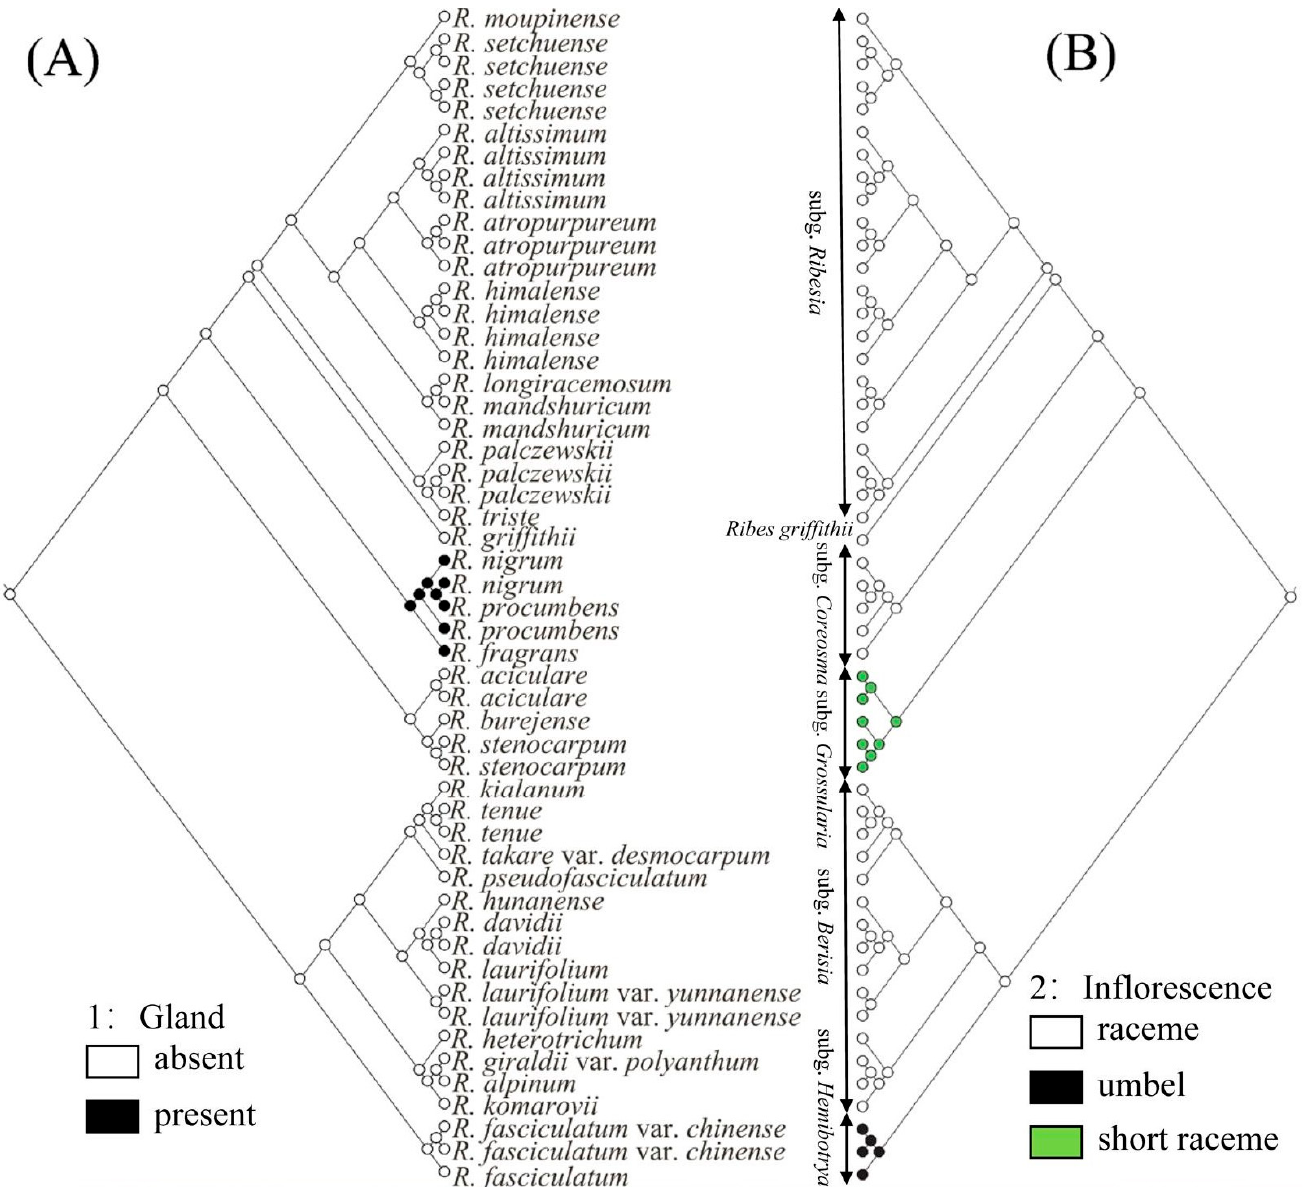
Figure 4. Ancestral state reconstructions for ( A ) gland and ( B ) inflorescence based on the Mk1 model of the neighbor-joining tree. The corresponding color keys identify extant possible ancestral character states. Pie diagrams at internal nodes indicate the relative probabilities for each alternative state.